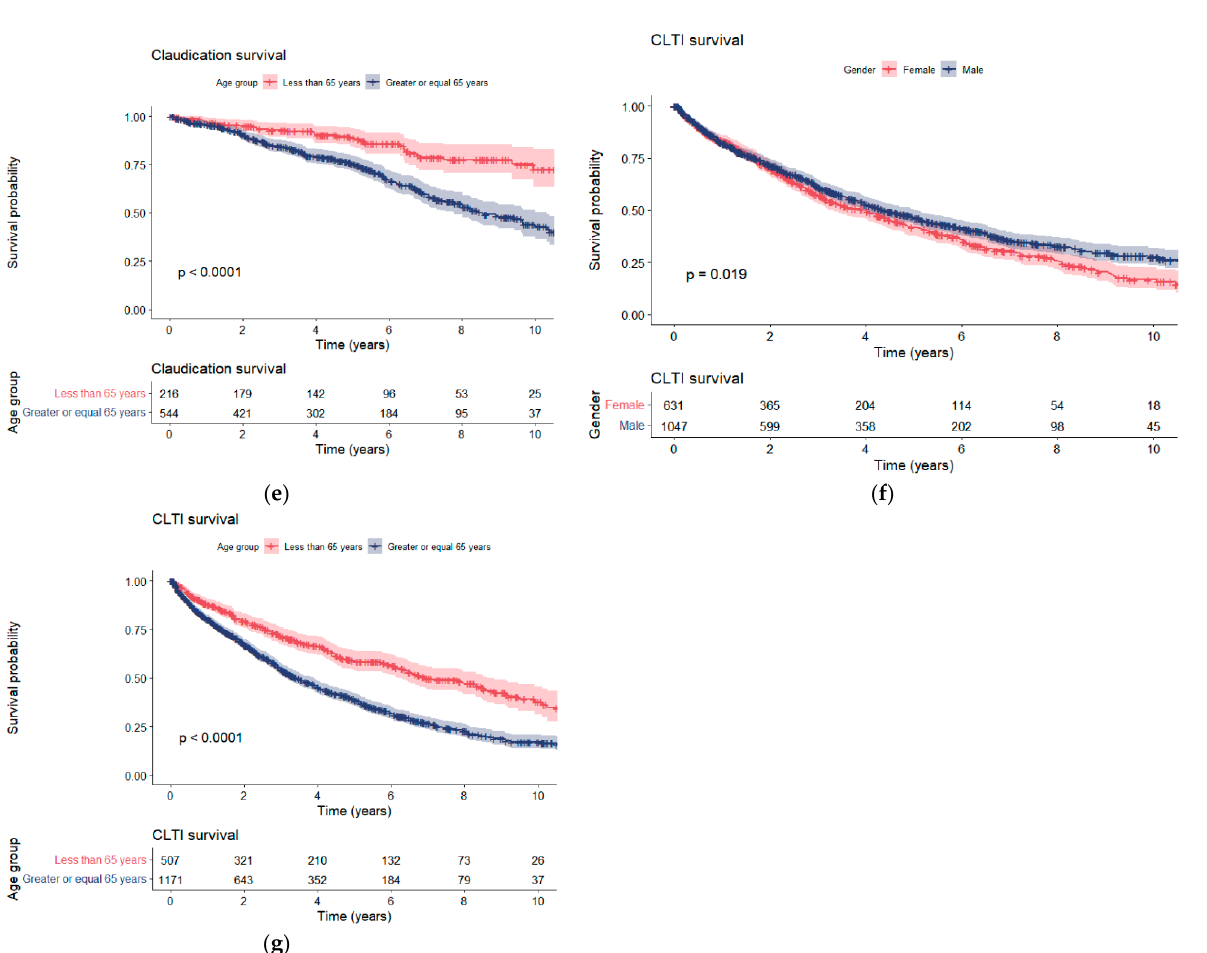
Figure 4. Kaplan–Meier survival curves for ( a ) sex stratification of patients with PAD (combined short-distance IC and CLTI cohorts), ( b ) age stratification of patients with PAD (combined short-distance IC and CLTI cohorts), ( c ) short-distance IC compared to CLTI cohort, ( d ) sex stratification of patients with short-distance IC, ( e ) age stratification of patients with short-distance IC, ( f ) sex stratification of patients with CLTI, and ( g ) age stratification of patients with CLTI.